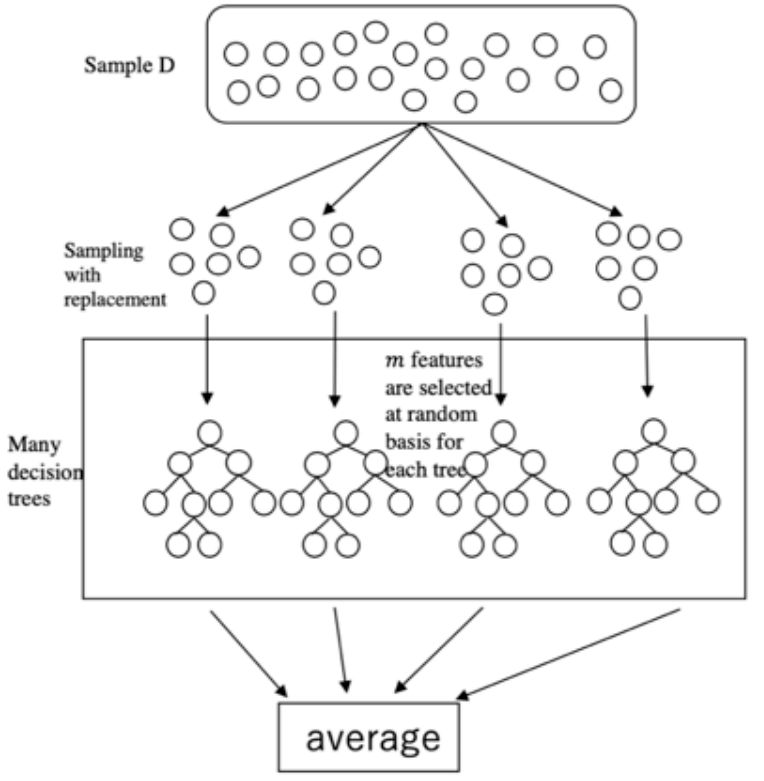
Figure 1. Mechanism of random forest.